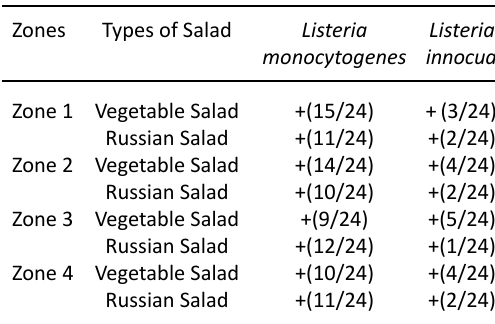
Table 5. Biochemical testing of Listeria spp. Zones Types of Salad Listeria Listeria monocytogenes